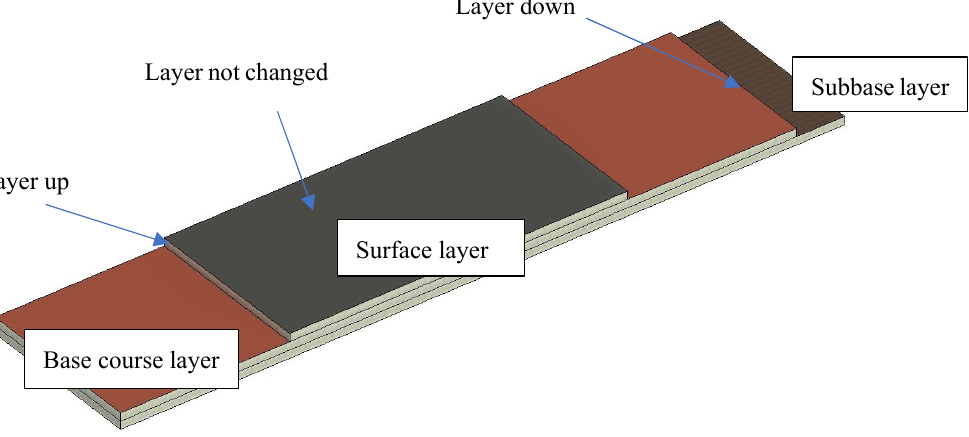
Figure 1. Layer changes between adjoining road layers along the as-built road length during construc- tion .